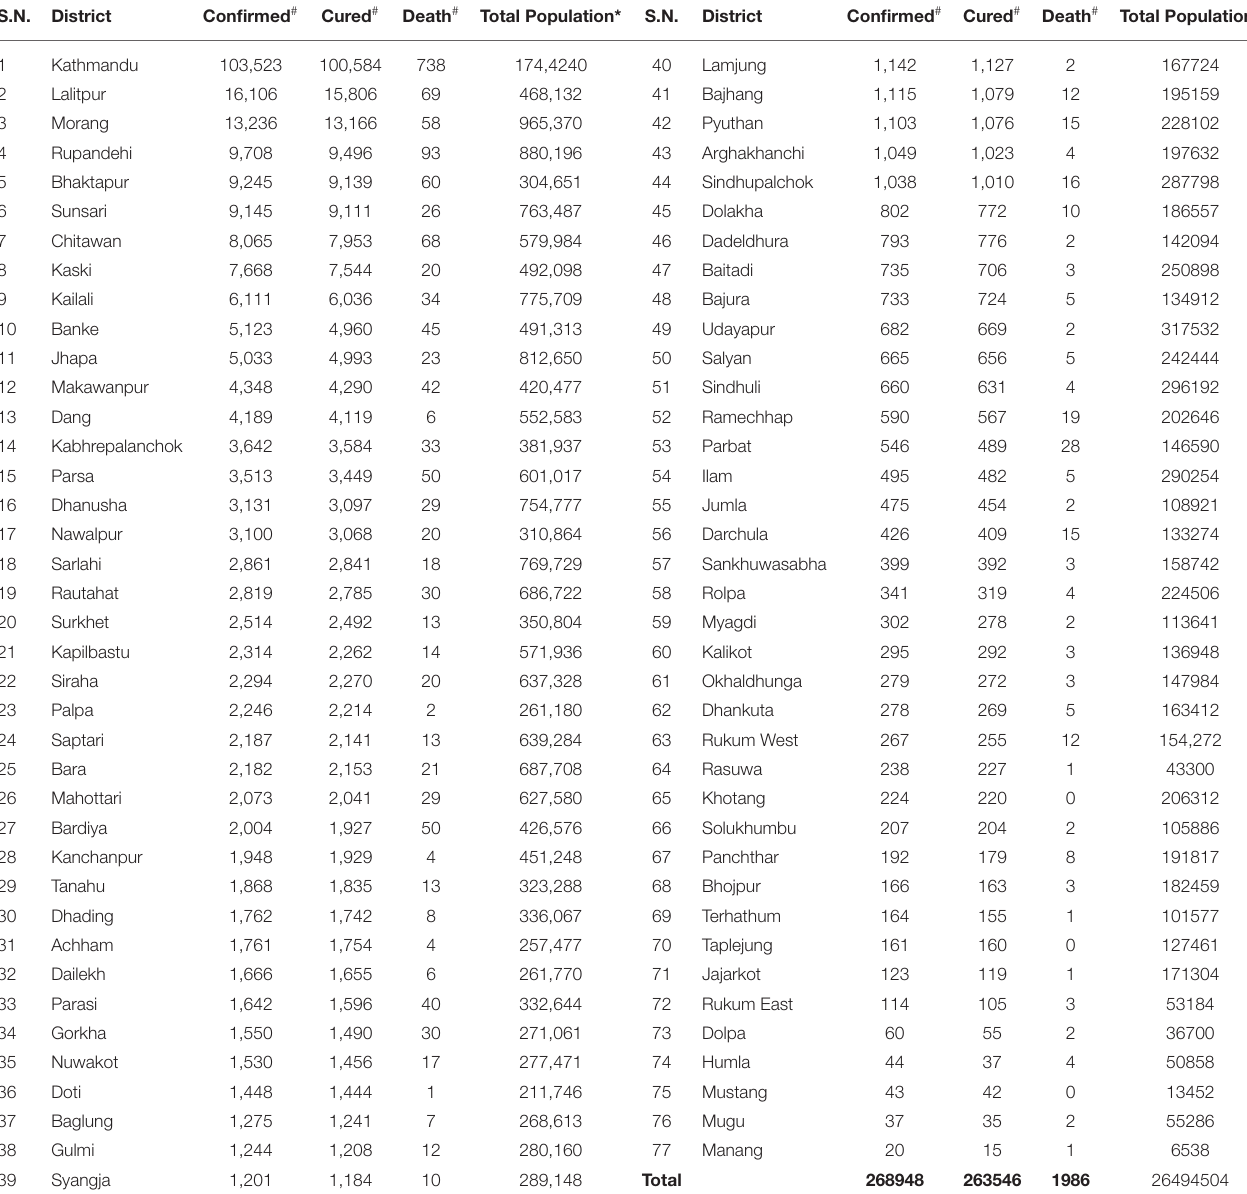
TABLE 2 | District wise distribution of confirmed cases, recoveries, and deaths due to COVID-19 and total population in Nepal. S.N.